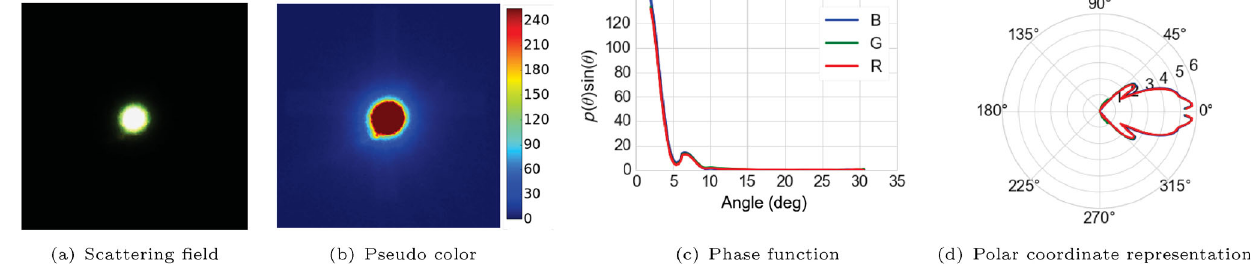
Fig. 7 Experimental result for wine. (a) Scattering field captured through screen at bottom. (b) Pseudo-color of captured scattering field. (c) Measured phase function versus scattering angle. (d) Polar plot of phase function. The incident direction is from left to right and intensity is given on a log scale.